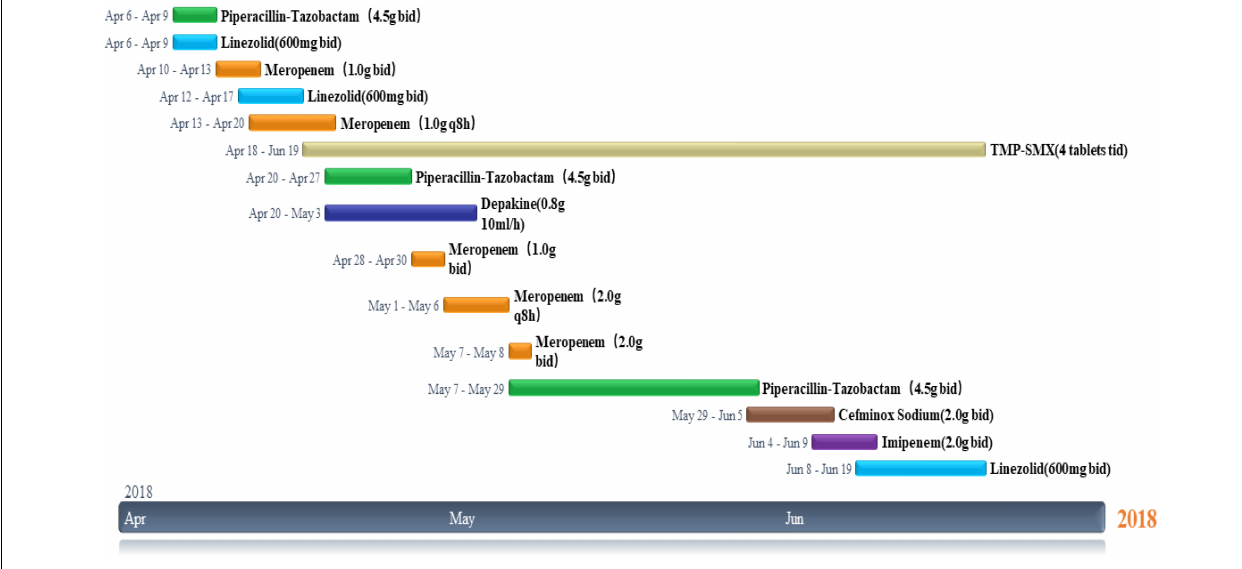
FIGURE 4 | Timeline of drug use during